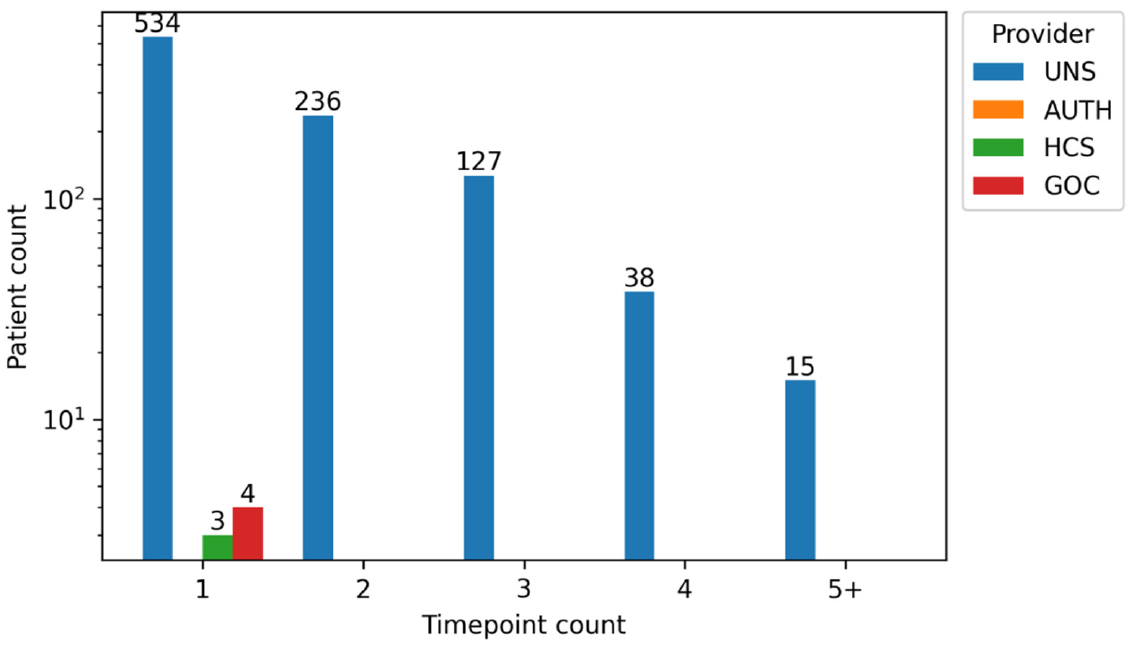
Figure 10. The number of patients with DBT images in different numbers of TPs in the INCISIVE retrospective database.